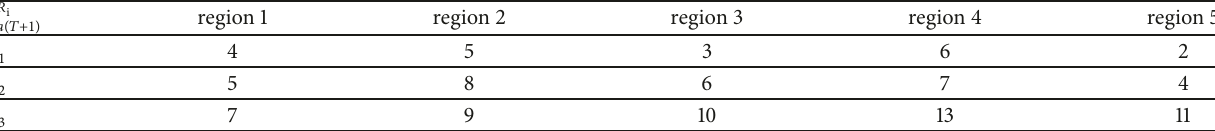
Table 4: The supply of materials in the current period of time the public observe.